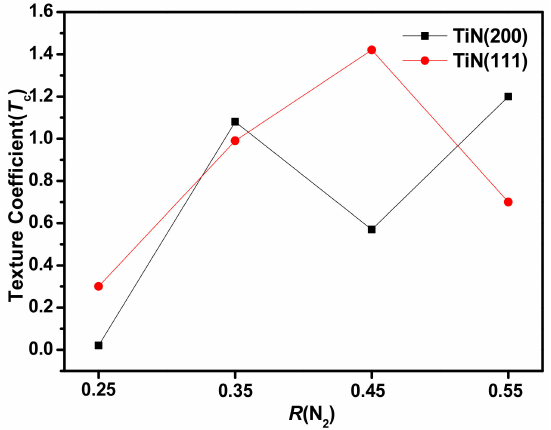
Figure 2. The texture coefficient of the TiN coating at different R (N 2 ).